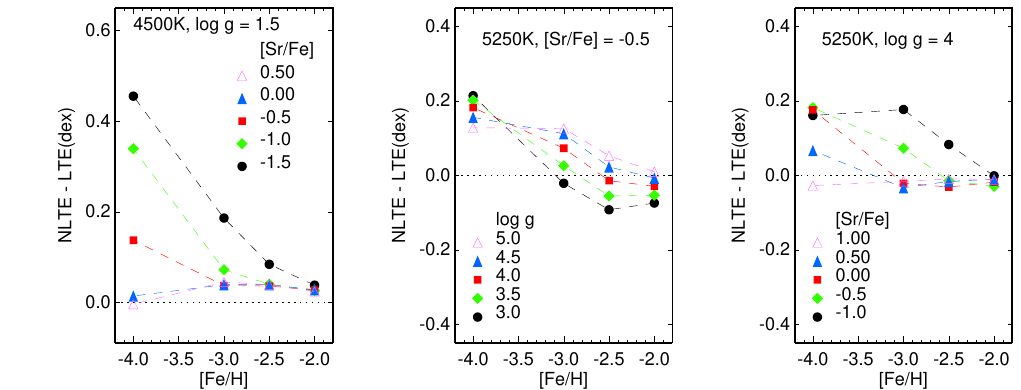
Figure 5. Non-LTE abundance corrections for Sr II 4077 Å in the model atmospheres of giants with common T eff = 4500 K and varied log g and [Sr/Fe] (two left panels) and dwarfs with common T eff = 5250 K and varied log g and [Sr/Fe] (two right panels) as a function of metallicity. We computed non-LTE abundance corrections for the Sr II 4077 and 4215 Å lines in two grids of the MARCS model atmospheres, which are applicable to VMP dwarfs and giants. For each node ( T eff /log g/[Fe/H]) of the grids, the calculations were performed with five [Sr/Fe] values. Everywhere, a microturbulence velocity of 1.5 km s − 1 was adopted. The grids cover the following ranges of atmospheric parameters and Sr